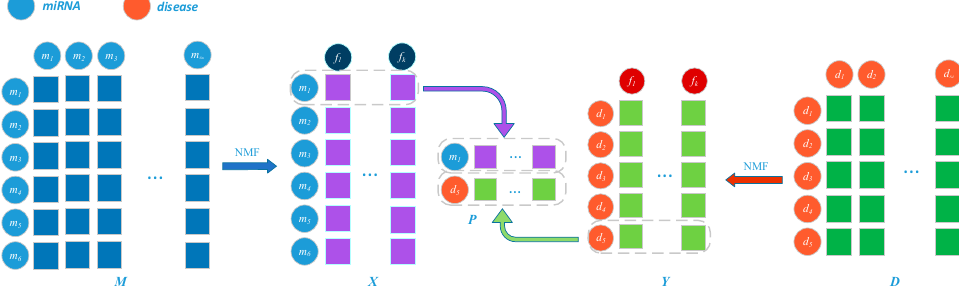
Figure 6. Establishment of the right embedding layer miRNA m 1 and disease d 5 by integrating their projection vectors in low-dimensional space.